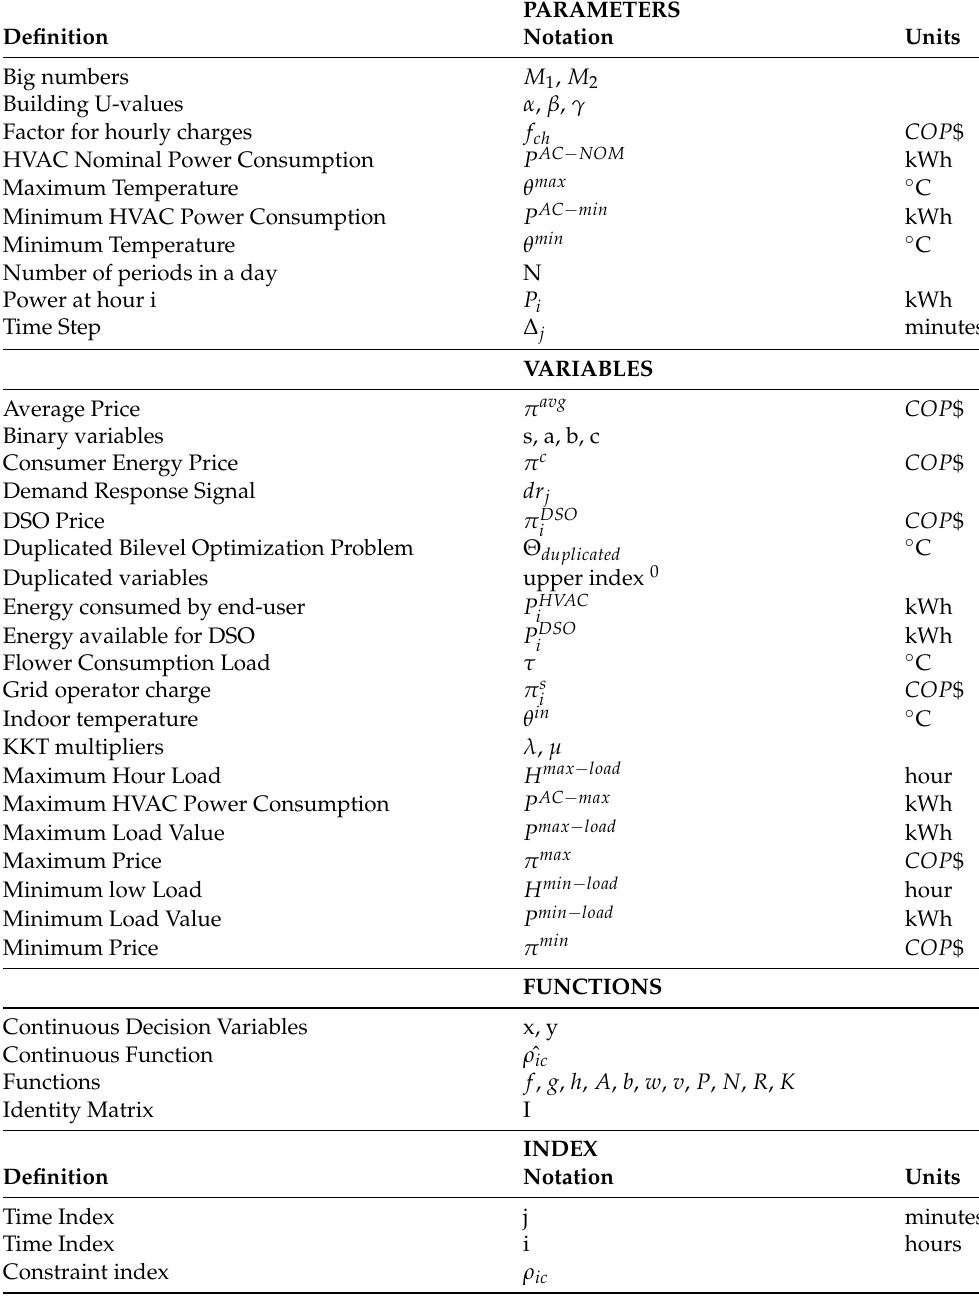
Table A1. Parameters, Variables, Functions, and Index